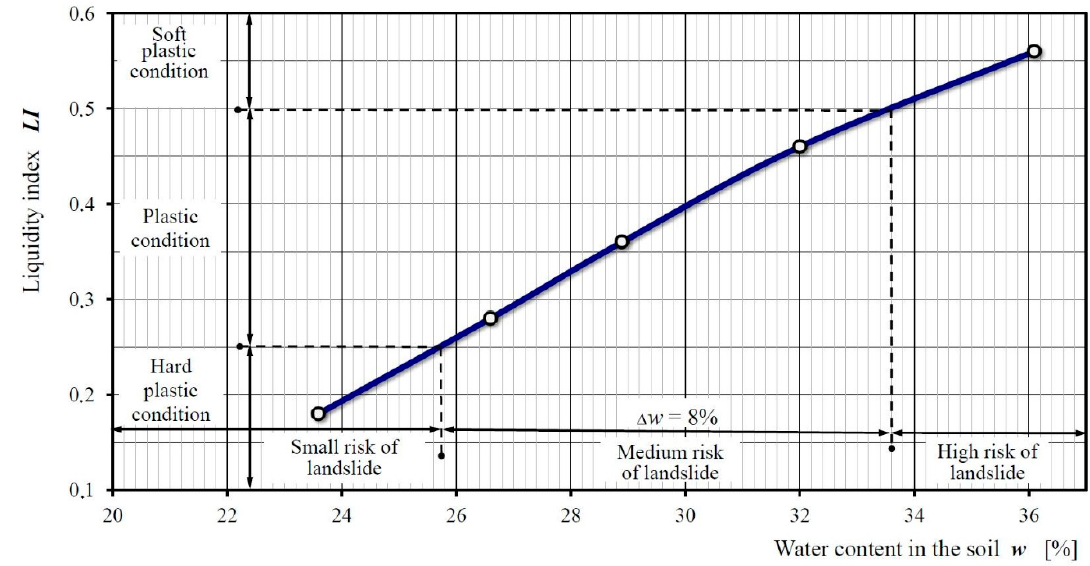
Figure 9. Diagram showing the relation between the TS state (liquidity index) in the soil contact layer and its water content.